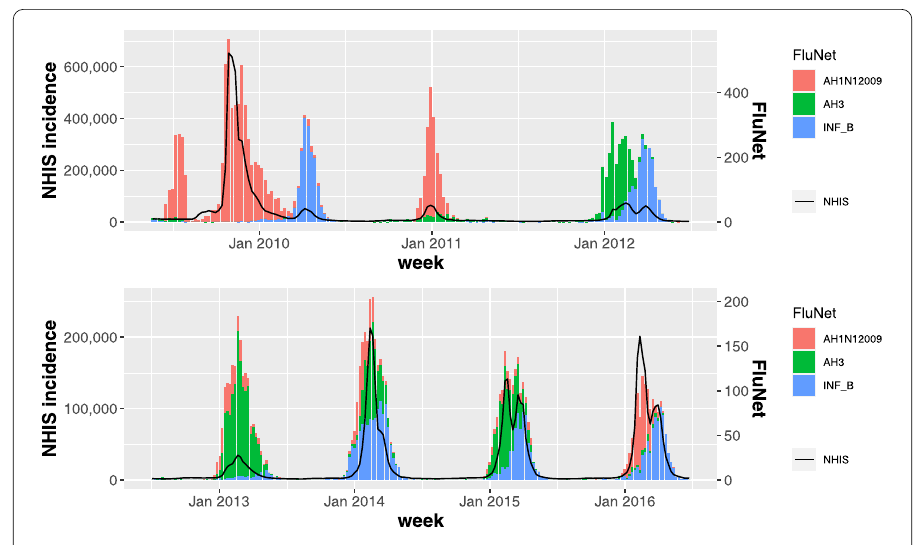
Figure 7 The time series of influenza incidence in South Korea (2009–2016). The black solid line shows the number of new patients within a week, which are extracted from the NHIS claims database. The histogram represents the numbers of influenza AH1N12009, AH3, and B virus isolates